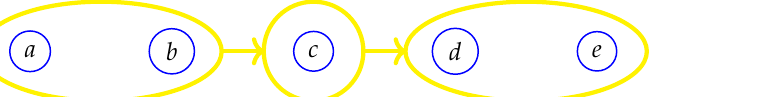
Figure 1. A resolvable network: ( { A , B , C , Source , Sink } , { ( A , B ) , ( B , C ) } ) , where A = { a , b } , B = { c } , C = { d , e }